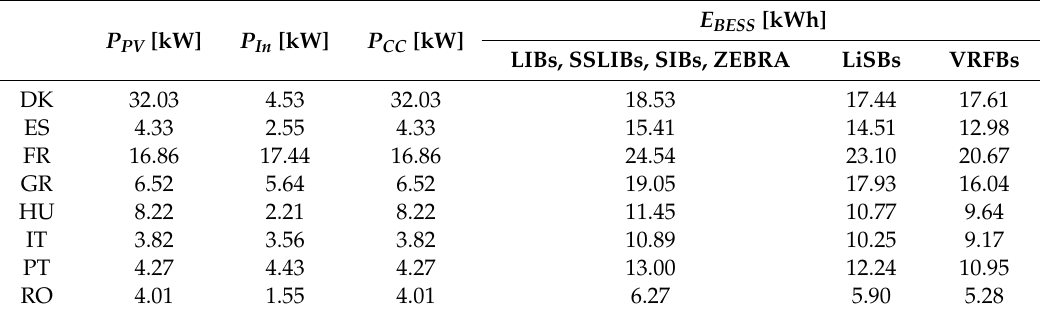
Table 8. Results of the design phase.